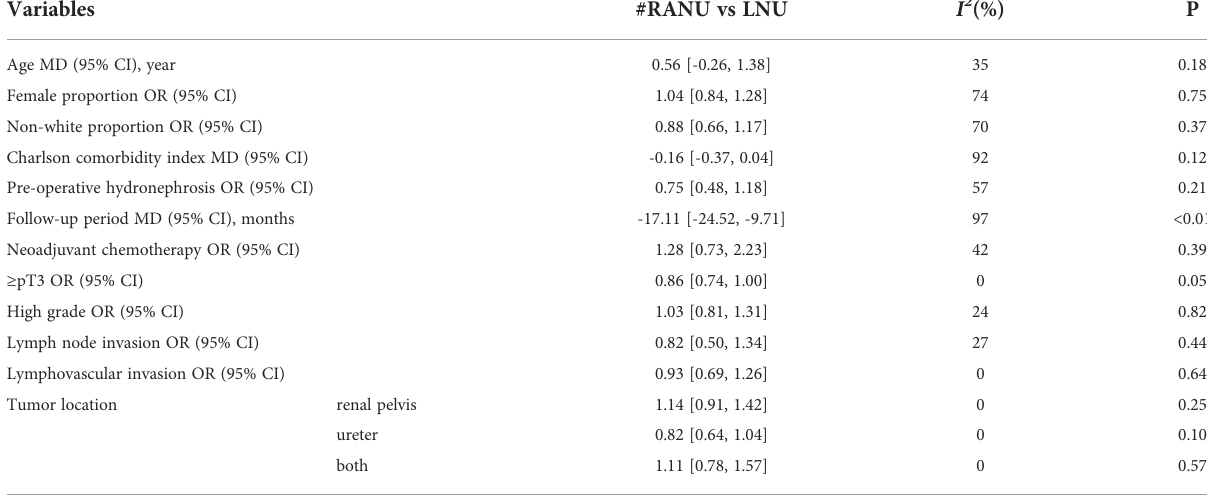
TABLE 2 Comparison of patient and tumor characteristics.